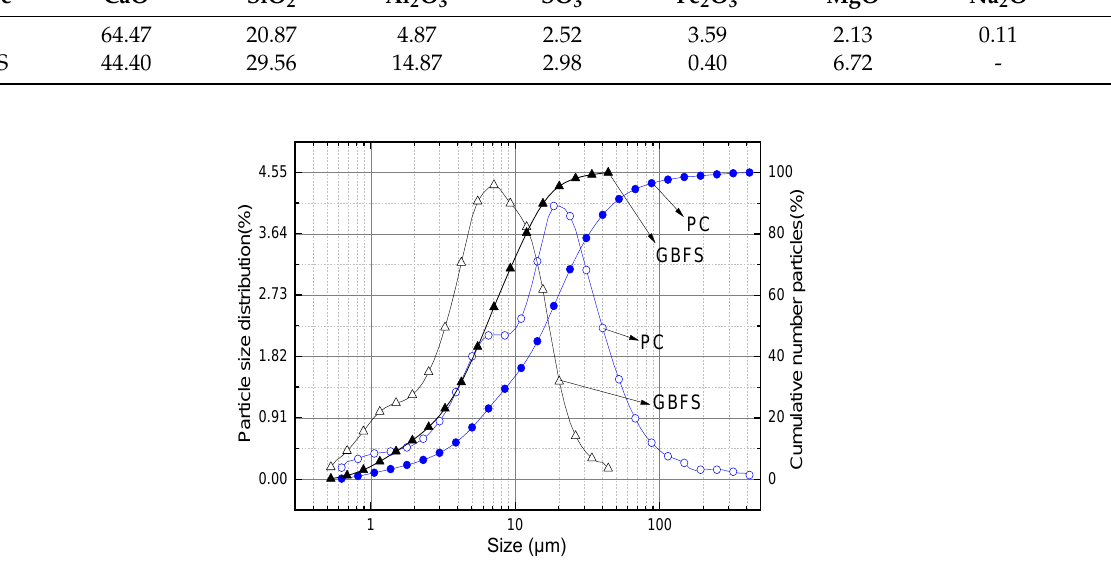
Figure 1. Particle size distribution of PC and GBFS.